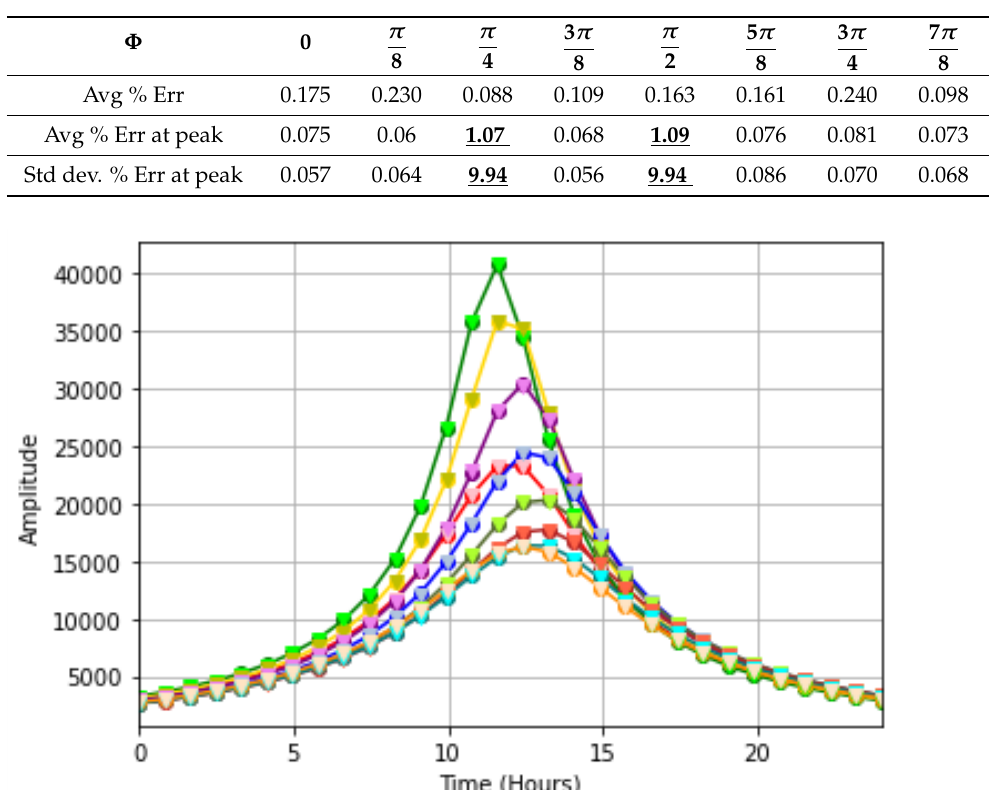
Table 4. Percent Error for CS reconstruction for each Φ for R = 7000 km. The second row shows average % error over all time samples, the third row shows average % error at peak magnification, and the last row shows the standard deviation of the % error at peak magnification.